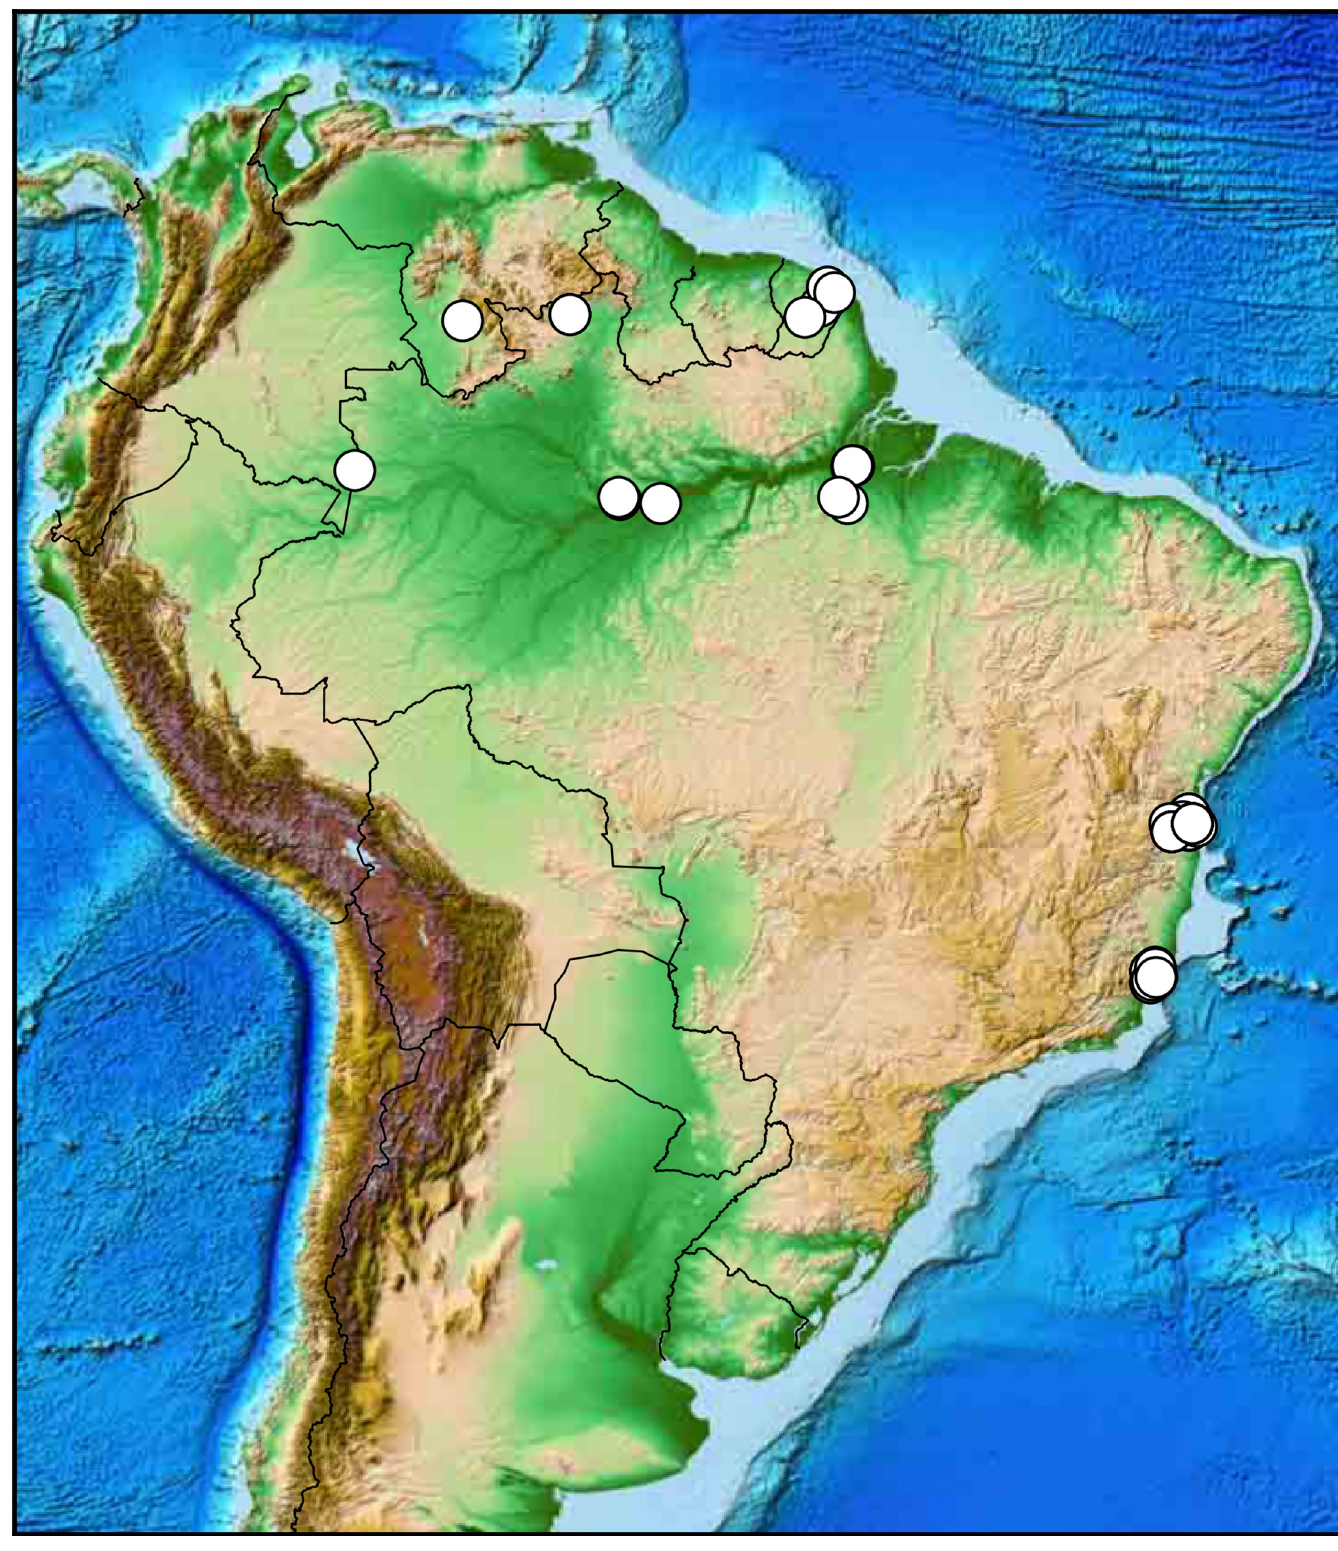
Fig 21. Distribution records for Cryptoxenodon metamorphus sp. nov. Terrain and vegetation projection. Built with Basemap (https://matplotlib.org/basemap/).